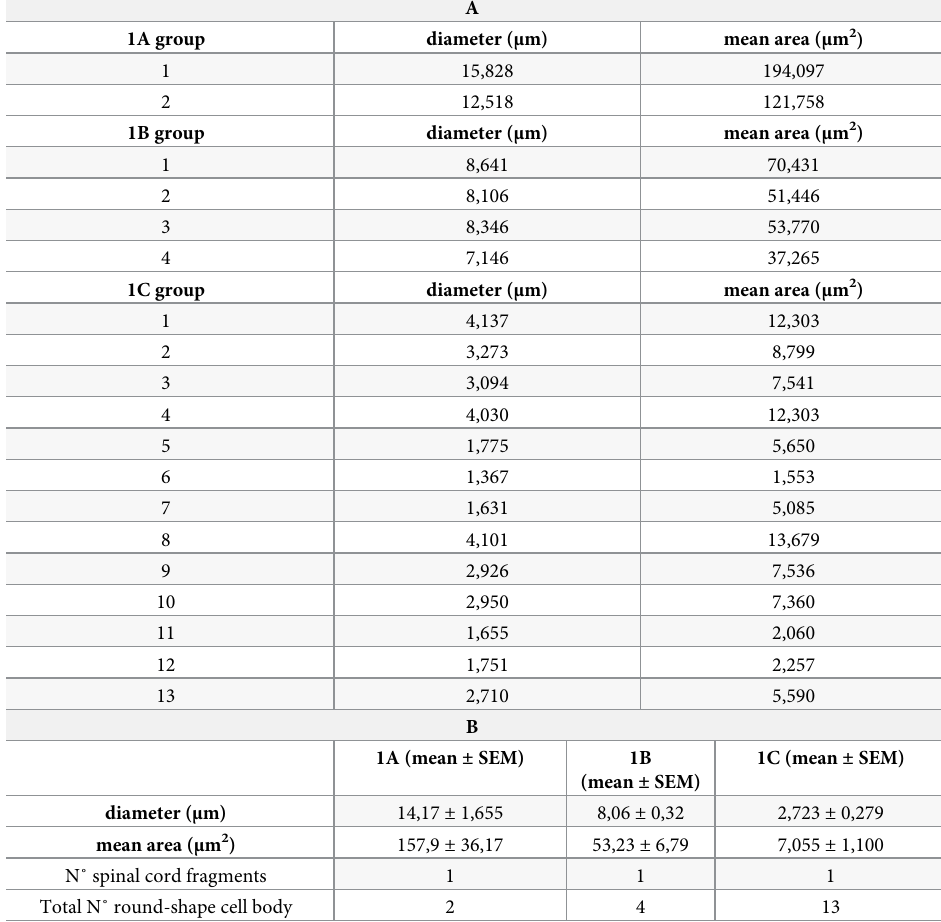
Table 1. Measures of diameter ( μ m) and mean area ( μ m 2 ) of cells from the spinal cord fragment showed in Fig 1B. A. Cell classification in three groups based on different size; B. Mean diameter and mean area of the three groups of